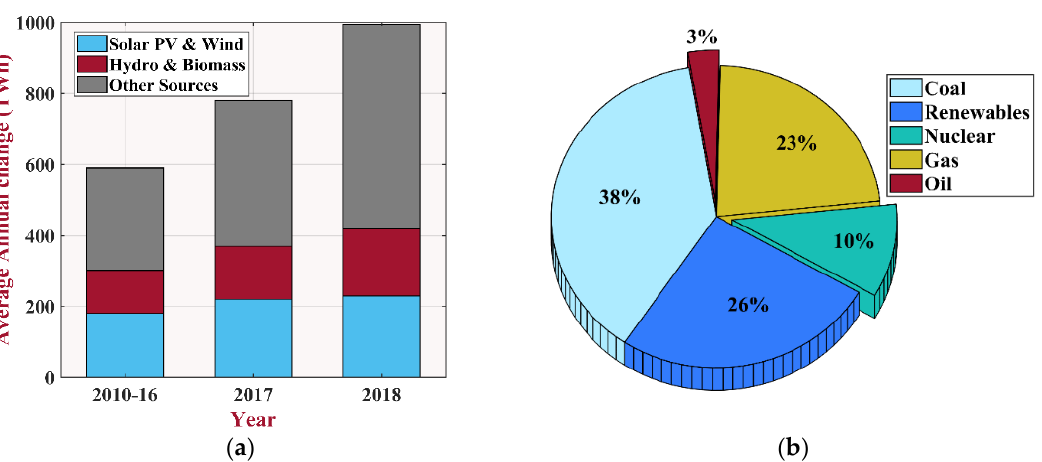
Figure 1. ( a ) The average annual change in electrical energy generation and ( b ) the electricity generation mix in 2018 [1].